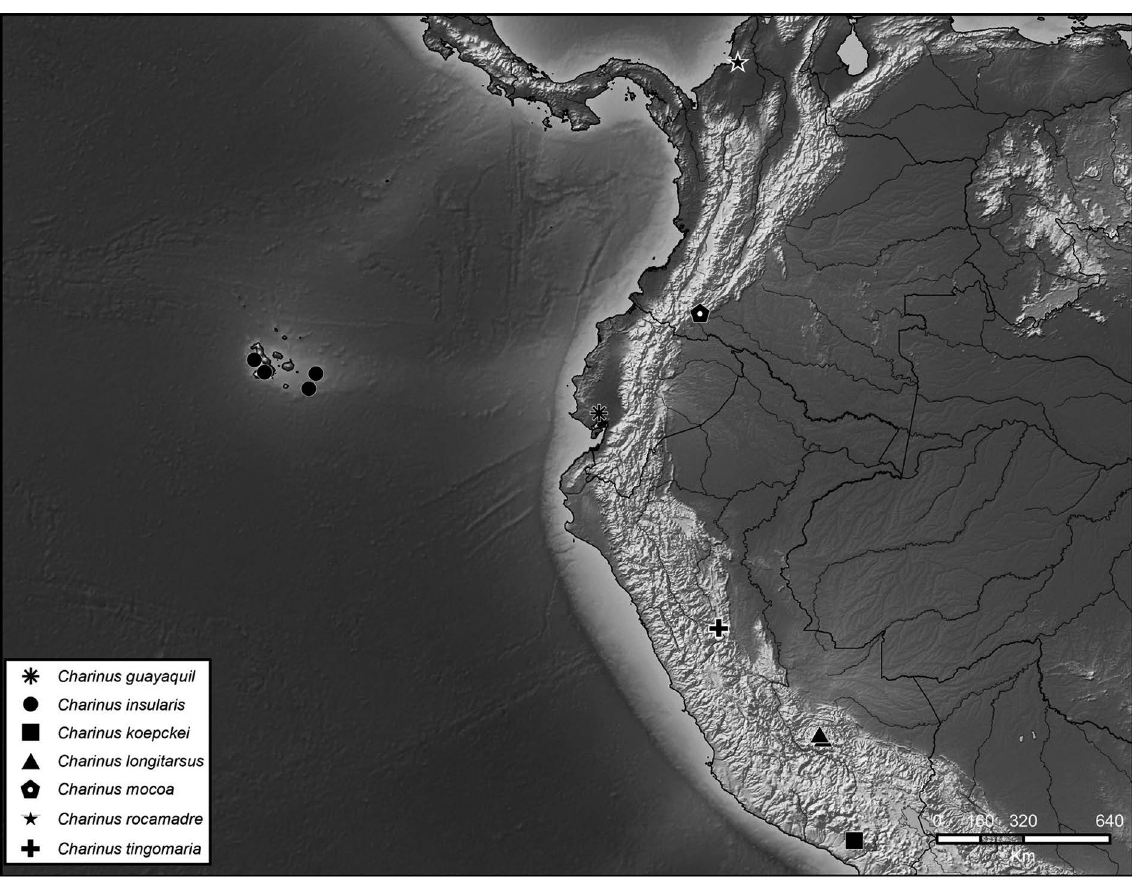
Fig. 34. Map plotting known distributions of species of Charinus Simon, 1892 in western South America.